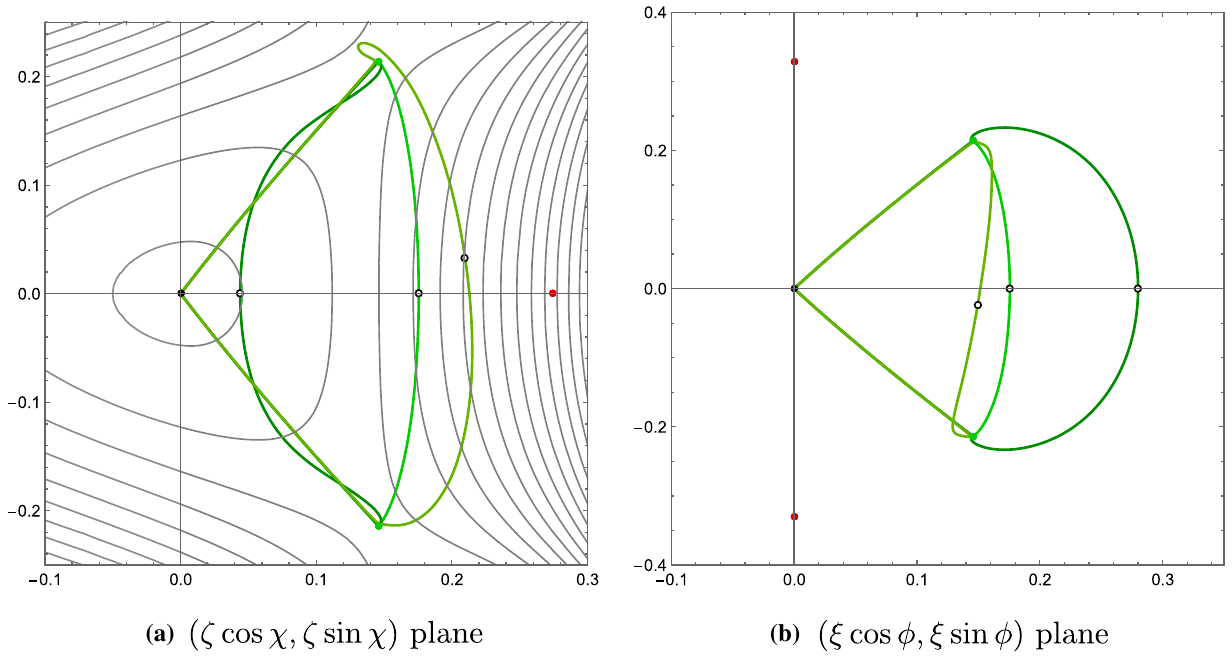
Fig. 5 Examples of a family of G 2 / G 2 Janus solutions on the contour plot of the superpotential